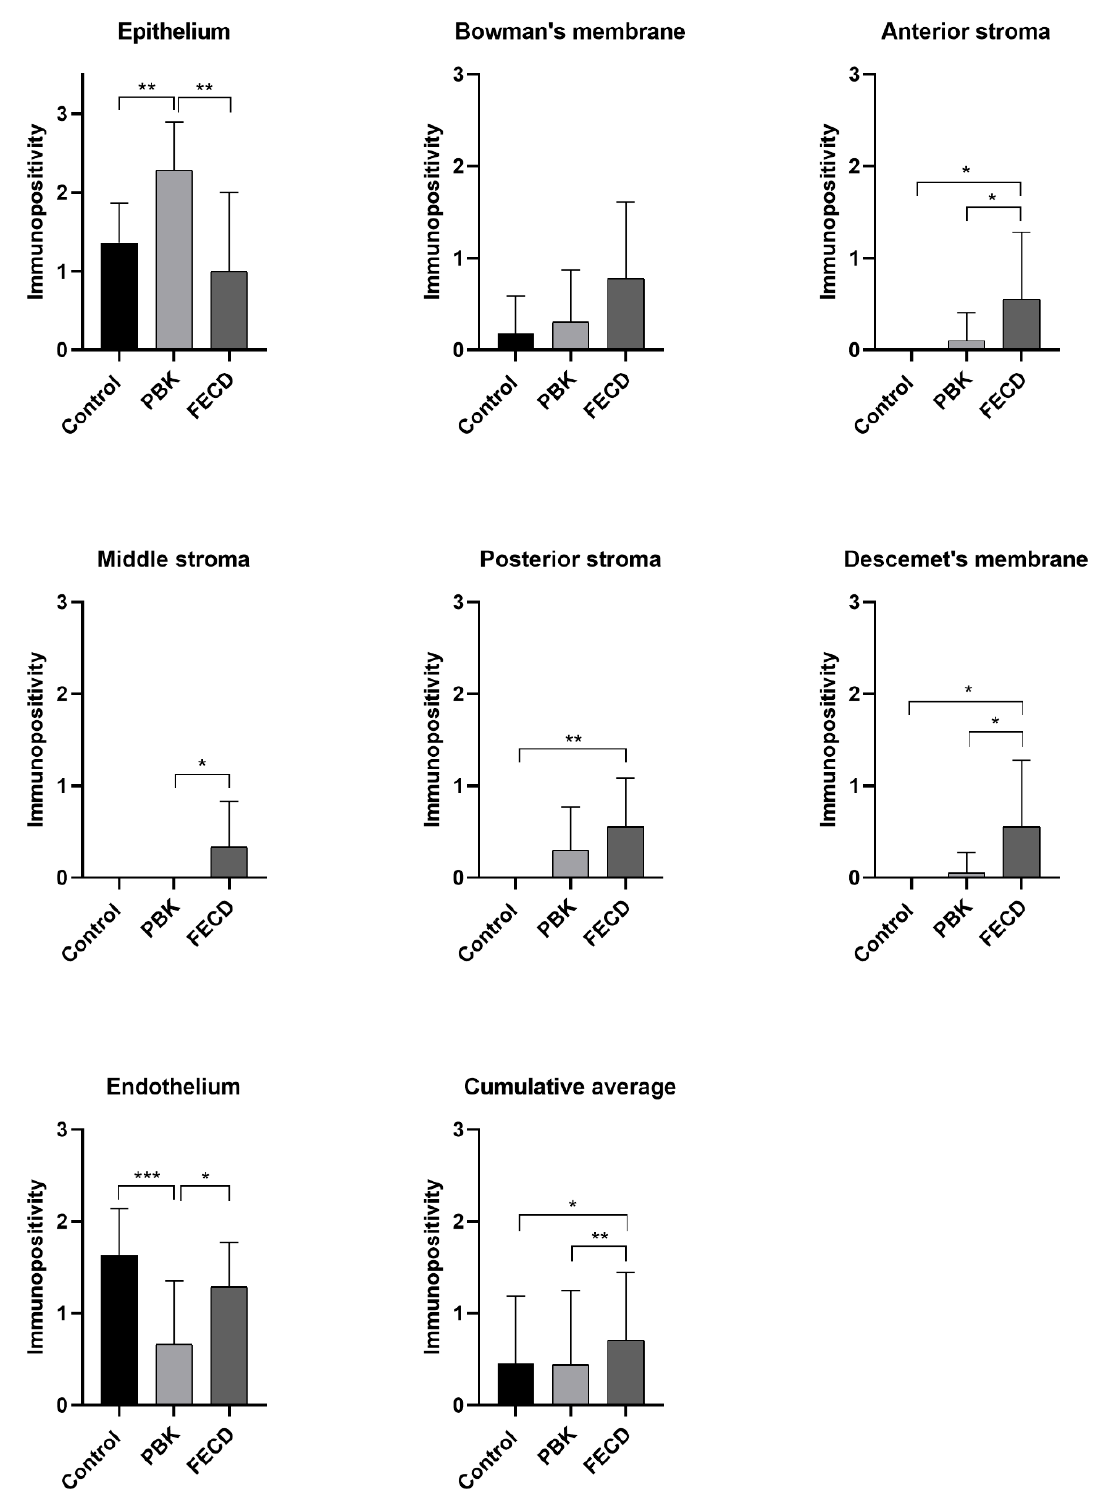
Figure 2. The average matrilin-2 immunopositivity in the different corneal layers in normal and pathologic conditions. PBK = pseudophakic bullous keratopathy, FECD = Fuchs’ endothelial corneal dystrophy. Columns indicate the average immunopositivity (0 means no staining, 0.5+ minimal, 1+ mild, 2+ moderate, 3+ marked positivity). * = level of significance ( p ˂ 0.05 *; p ˂ 0.01 **; p ˂ 0.001 ***).